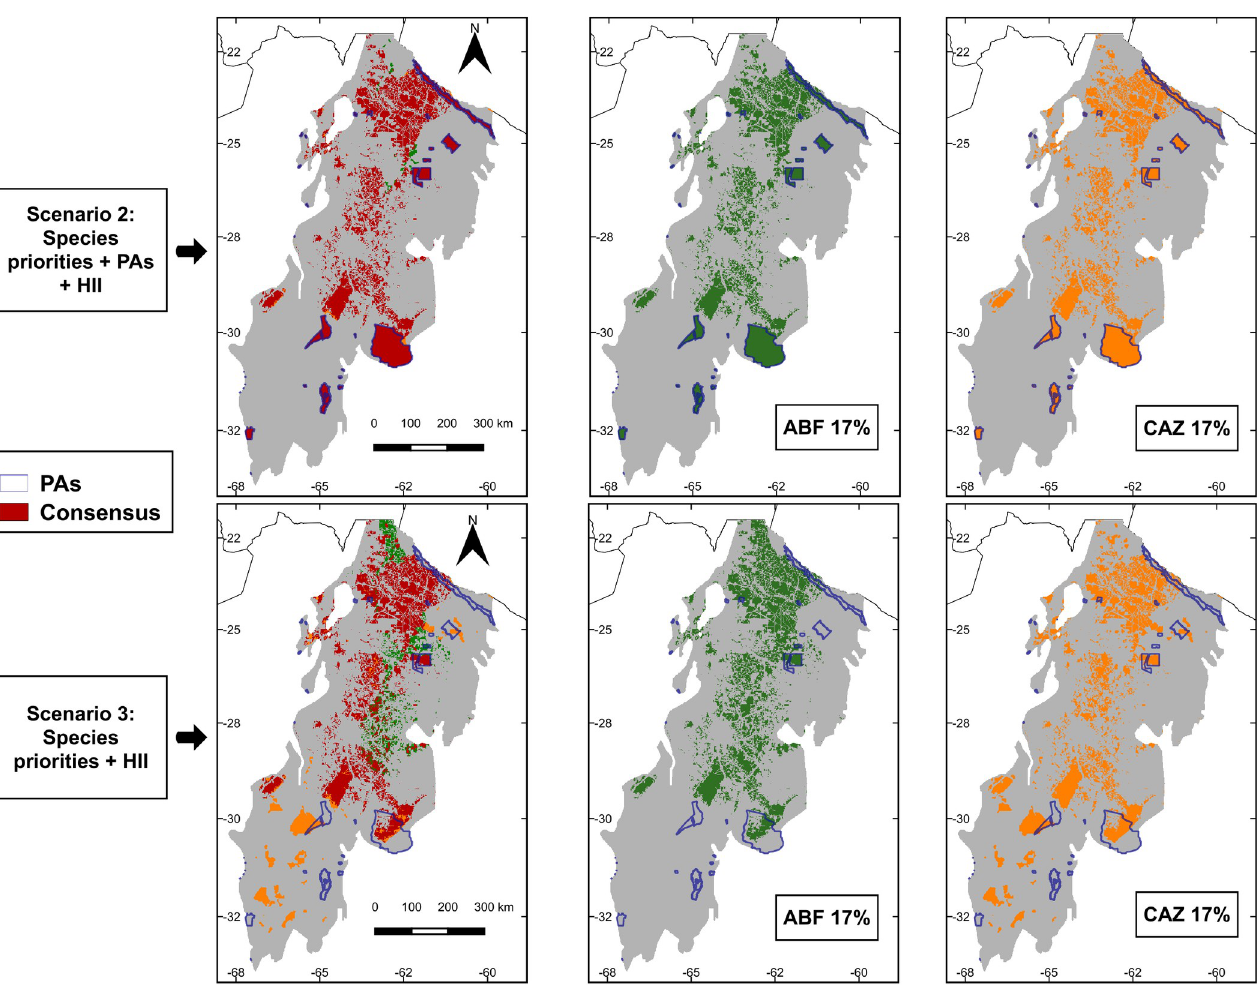
Fig 6. Maps showing the 17% of priority conservation for ABF (Added Benefit Function) and CAZ (Core Area Zonation) in Scenario 2 [Species individual weighted + PAs + cost (Human Footprint-HII)] and; Scenario 3 [Species individual weighted + cost (HII)]. Red pixels correspond to the consensus areas selected by both CAZ and ABF prioritization schemes for conservation snakes and which also complement current PAs system of the Argentinian Dry Chaco forest. Those selected by only one prioritization scheme are shown in green (ABF) or orange (CAZ).